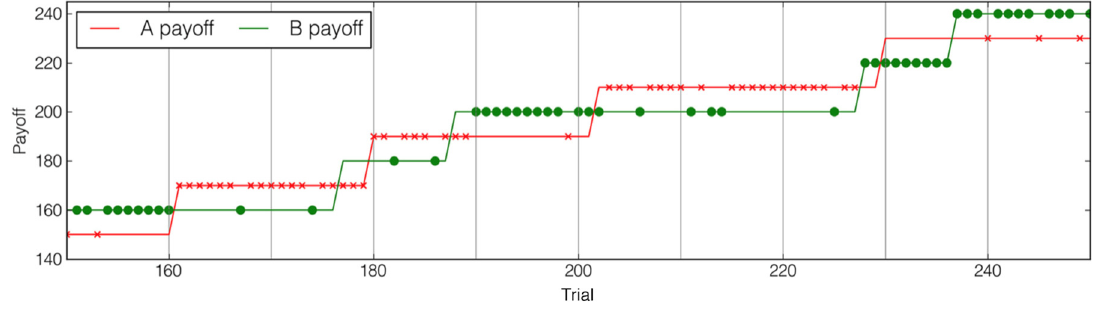
Figure 1. Example from [4] for the choice payoffs in the leapfrog task from trial 150 to trial 250. One of the options always features lower payoff, but also a random chance of becoming the higher payoff choice in the next trial (leapfrogging). Participants could only see the payoff of the options they chose and therefore had to decide whether to exploit the option that they believed to be better or explore the payoff of the other option to see whether it leapfrogged. The crosses and dots represent example choices of a